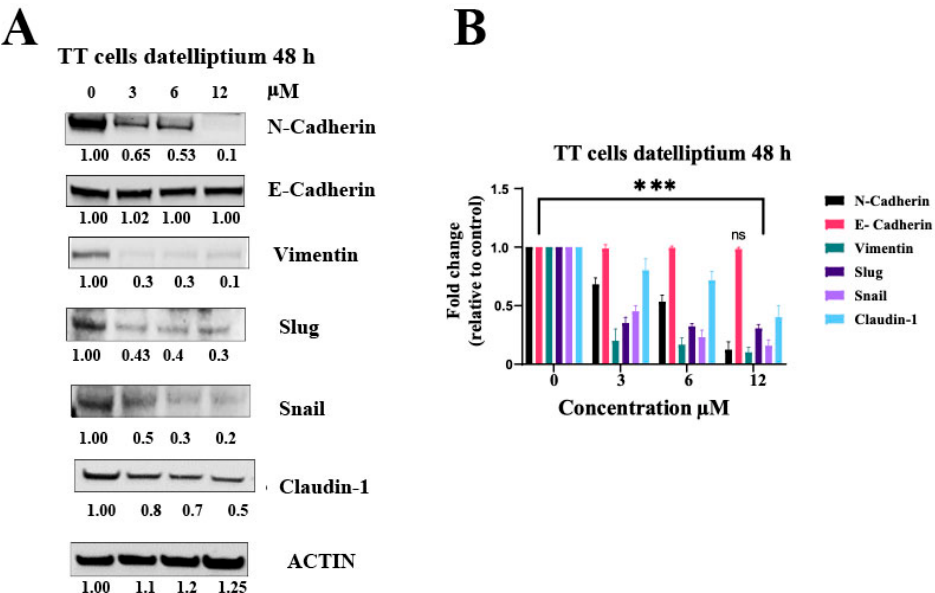
Figure 2. Inhibition of the epithelial-mesenchymal transition in TT cells by datelliptium. ( A ) The levels of each protein were analyzed by western blot after treatment with 3, 6, and 12 μ M of datelliptium. ( B ) Densitometry analysis of the western blotting in A; all proteins were normalized to their basal expression ( n = 3, *** p < 0.001, and ns = not significant) using one-way ANOVA with Tukey post-test.